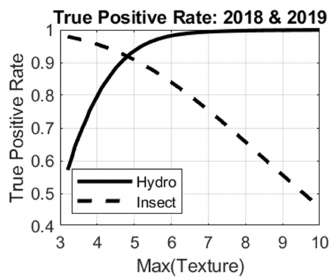
Figure A3. True positive rate (TPR) for truth hydrometeor and in- sect scattering observations for different orthogonal thresholds. As (cid:104) (cid:105) T dB max increases, the threshold moves from left to right up the curve y = 0 . 279 x − 0 . 095 shown in Fig. A2b and e. The solid line is TPR hydro and the dashed line is TPR insect . The intersection occurs (cid:104) (cid:105) = 4 . T dB when max